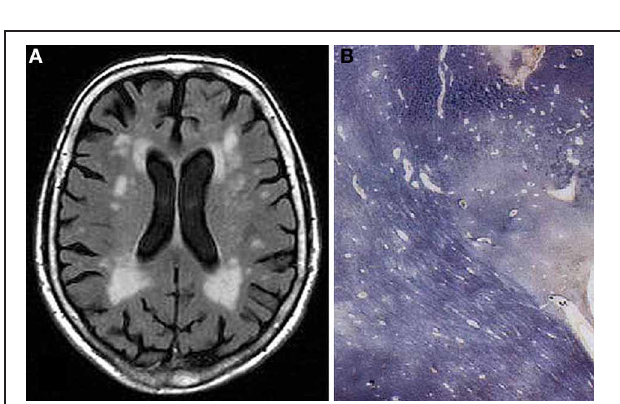
FIGURE 4 | Confluent hyperintensities in deep and periventricular white matter in 77 years old female without neuropsychiatric disorder or cognitive impairment. (A) T2-weighted FLAIR-MRI scan. (B) Multiple white matter changes with patchy myelin loss, perivascular empty spaces, small lacunes, and periventrivular myelin pallor (Kluver-Barrera stain).